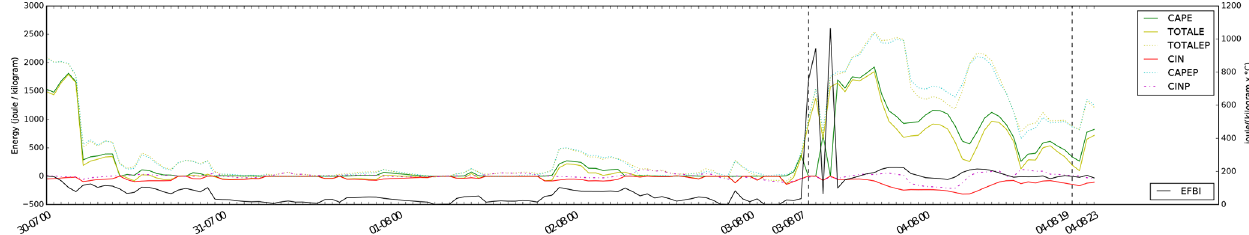
Figure 3. Sample of the timeline of the EFBI (right vertical axis) and the factors used (left vertical axis) for the wildfire in Sala (2014, Sweden) that burnt close to 10000ha from 3 to 4 August 2014 (time period marked with vertical dashed lines). Horizontal axis is the timeline using hourly steps in the format dd-mm hh. TOTALE = CIN + CAPE. TOTALEP = CINP + CAPEP.